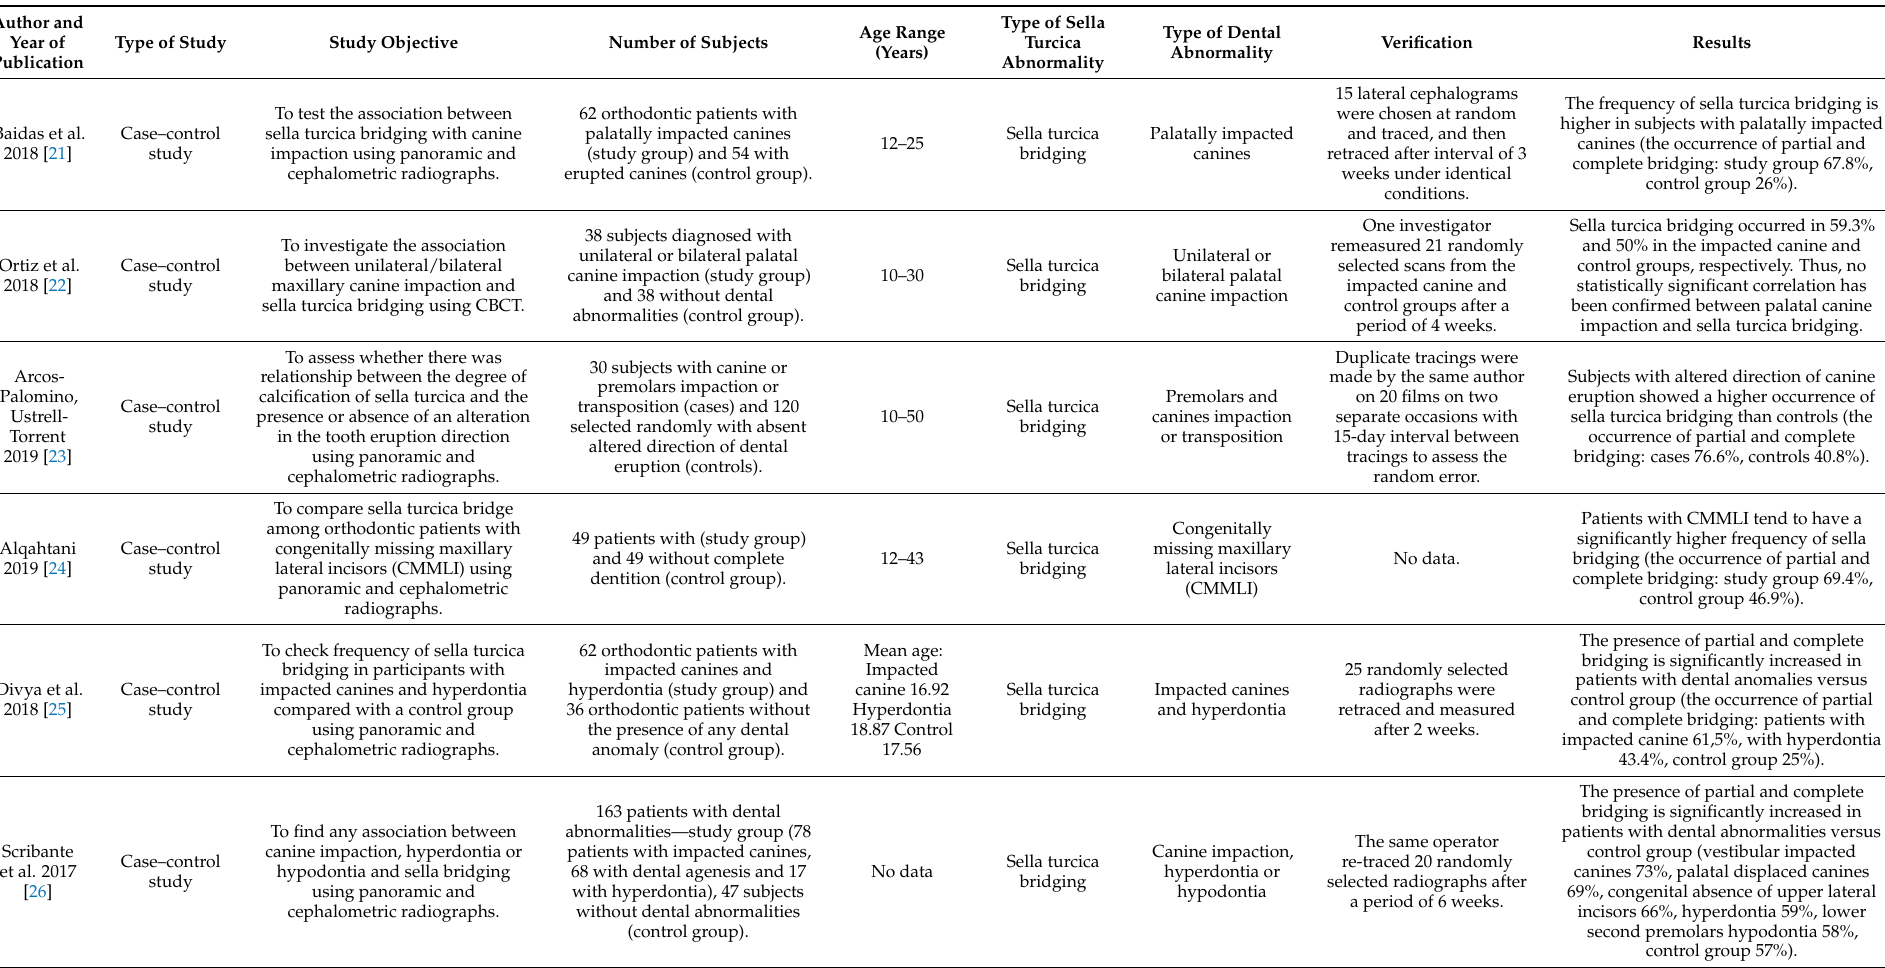
Table 1. Characteristics of included